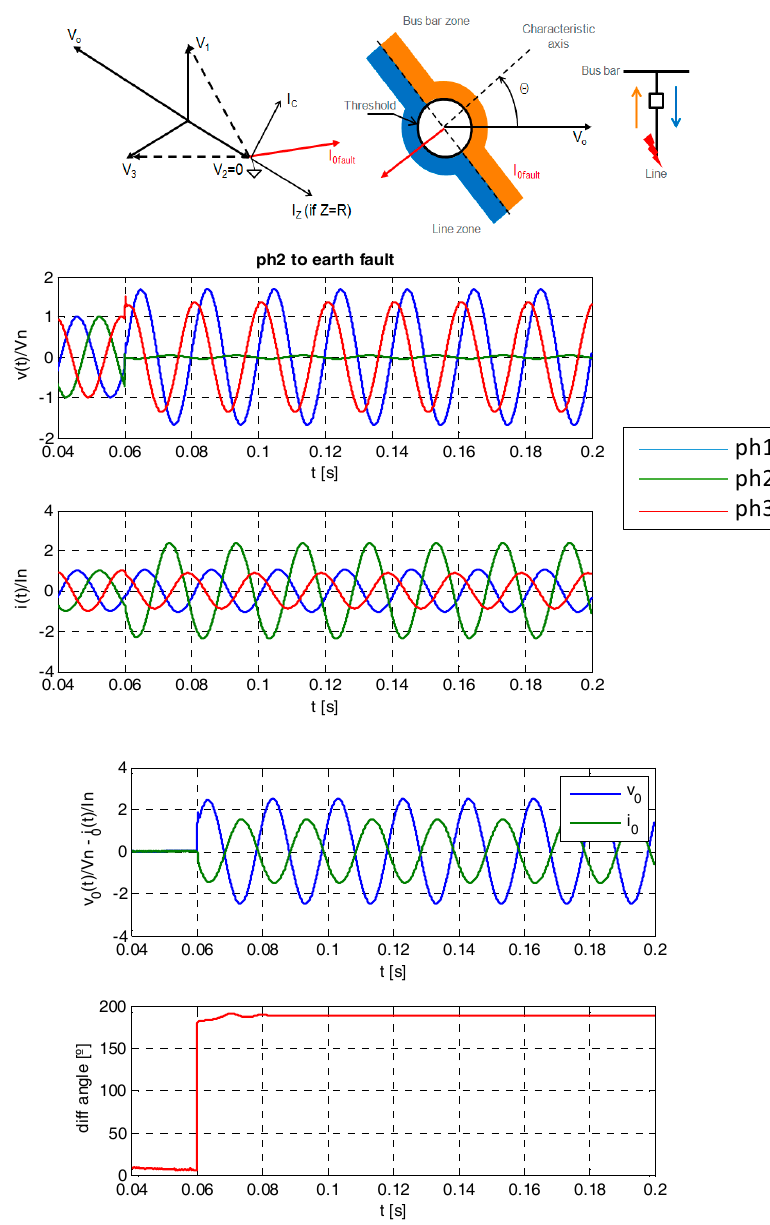
Figure 1. Earth fault detection and waveforms example.